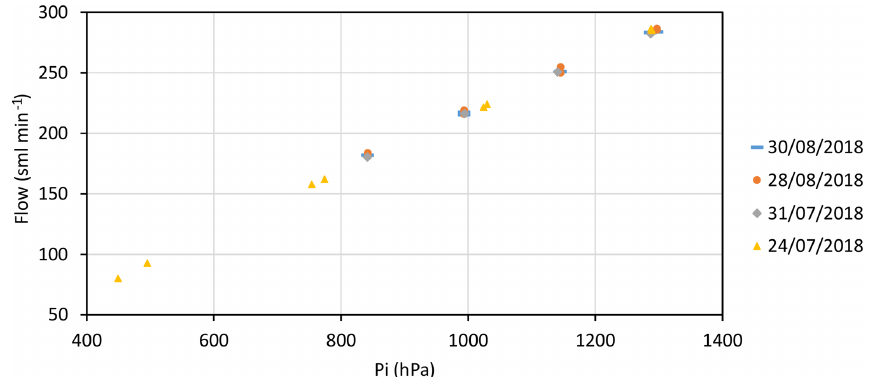
Figure 1. Results of tests performed on 4 non-consecutive days in which dry natural air coming from a standard was measured during many consecutive hours changing the CRDS inlet pressure every hour or longer. p i is the CRDS inlet pressure and “Flow” is the flow measured downstream of the